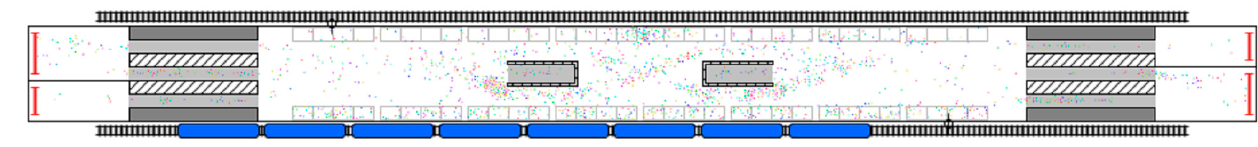
Figure 23. Passengers wait for the train.